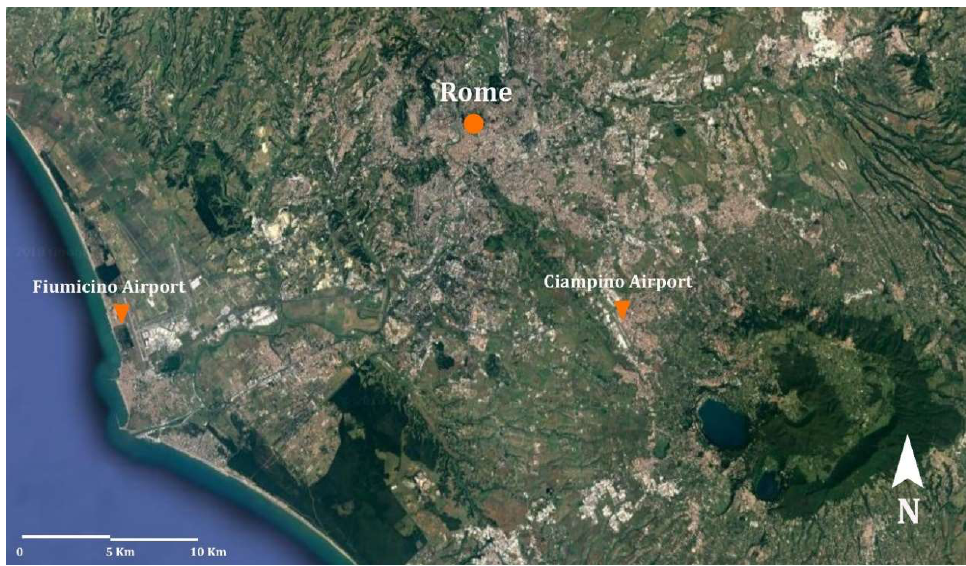
Figure 2. Aerial photo of the Rome metropolitan area and locations of the airports of Fiumicino and Ciampino.